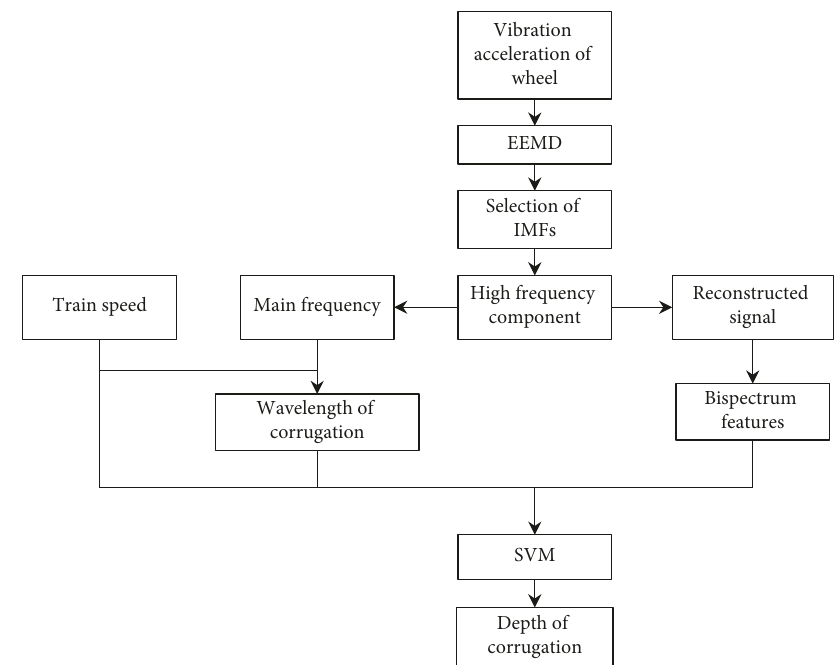
Figure 5: Rail corrugation detection